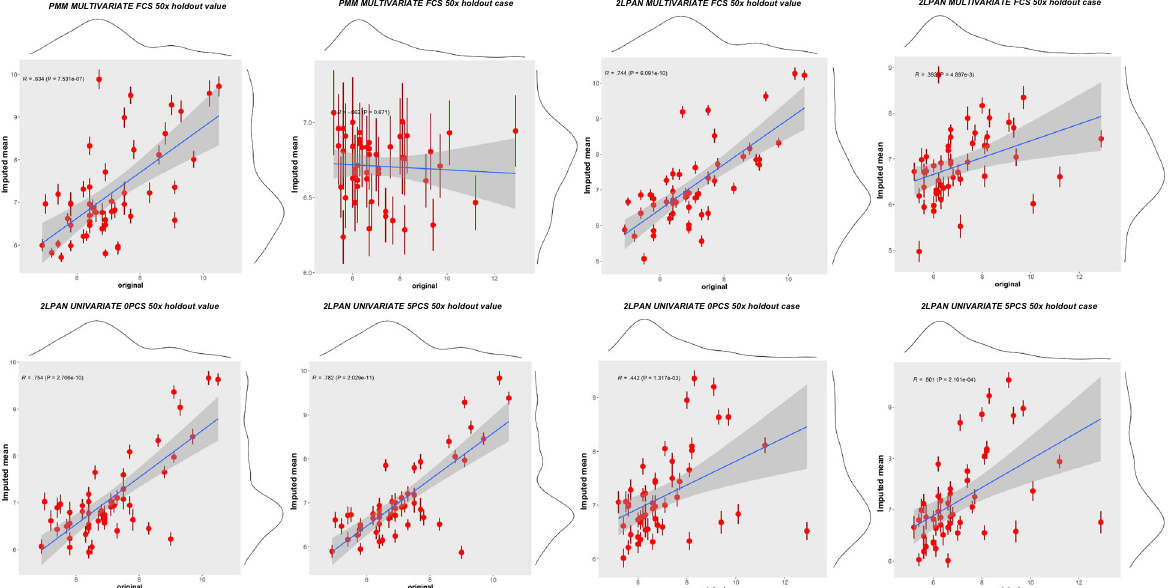
Fig. 7 Over-imputation plot demonstrated the mean and standard error of imputed values for the observed 50 holdouts where imputed values would lie if they were missing in the GNSIS dataset using HbA1c as an example. The lm fi t line with 95% CI was superimposed on the scatter plot. The Pearson ’ s correlation coef fi cient ( R ), as well as the signi fi cance of this correlation between 50 holdouts and imputed mean values were also present. This R -value represented the optimal correlation coef fi cient, which could be reached by each MI algorithm under multivariate or univariate setting. The kernel density plots at the margin of the scatter plot represented the corresponding distribution of observed and imputed 50 holdouts. Upper panels represent multivariate missing imputation using PMM or 2LPAN for HV or HC; Lower panels represent univariate missing imputation using 2LPAN with or without PCs derived from a comorbidity matrix as auxiliary